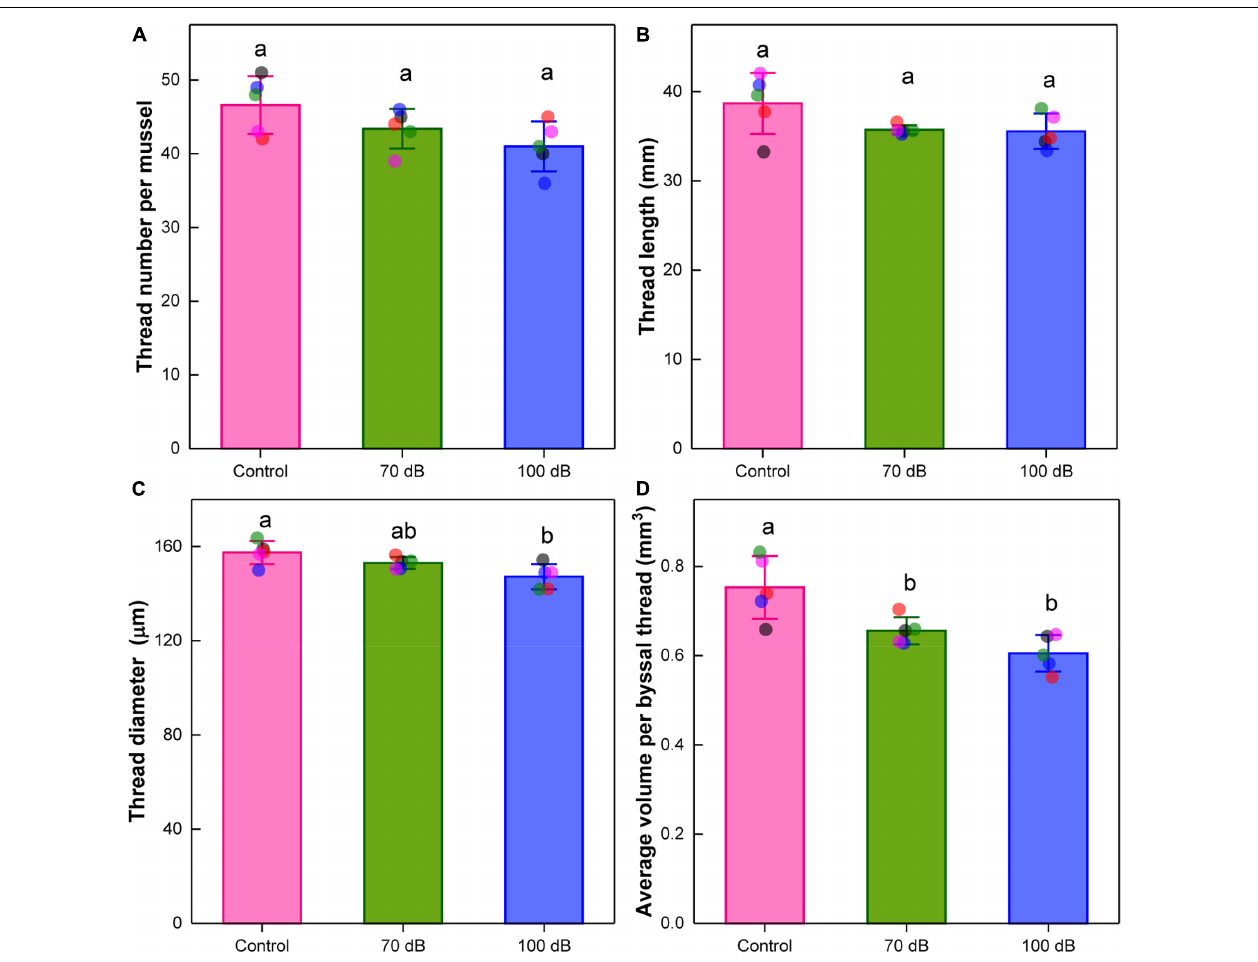
FIGURE 2 | Effects of anthropogenic noise exposure on the (A) number, (B) thread length, (C) thread diameter, and (D) volume of byssal threads newly produced by the thick shell mussel Mytilus coruscus ( n = 5 per group, mean ± SD). Means not sharing the same superscript are significantly different (Tukey’s HSD, p <